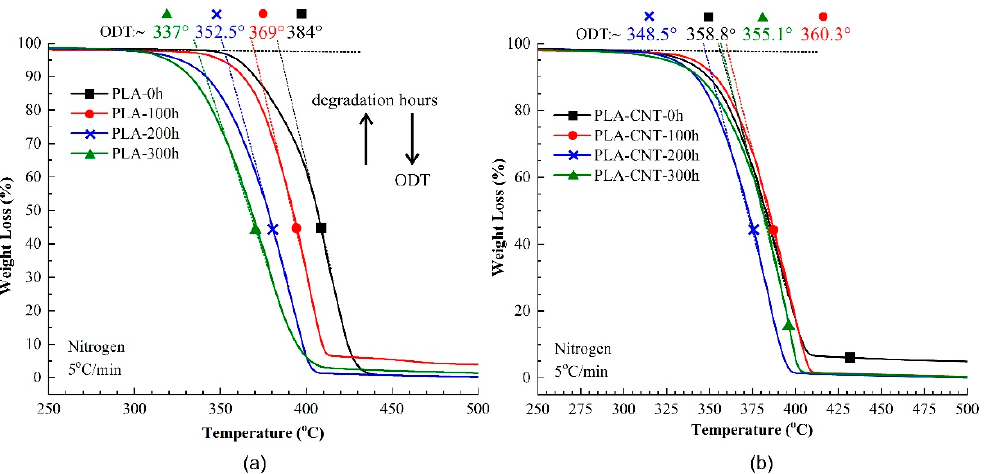
Figure 6. Comparison of thermogravimetric analysis (TGA) of ( a ) pure PLA and ( b ) 1% wt. PLA-CNT nanocomposites, at different degradation times.